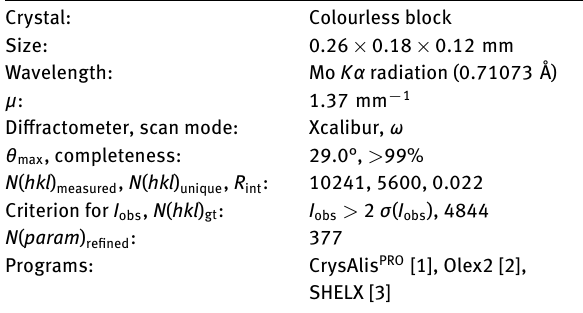
Table 1: Data collection and